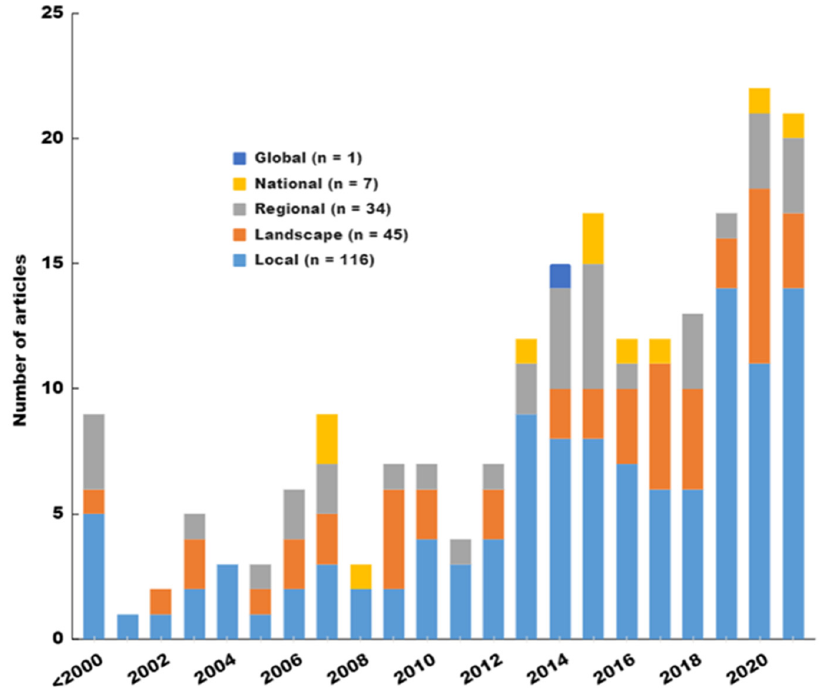
Figure 5. Frequency of studies conducted at different spatial scales (i.e., the extent of the study areas).